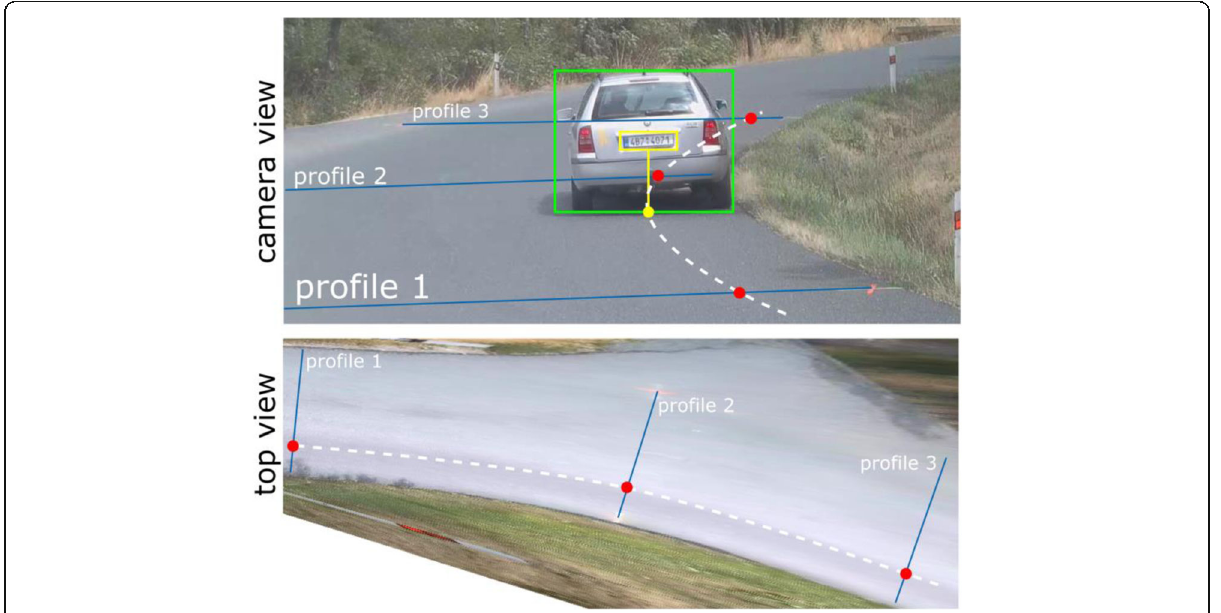
Fig. 5 Illustration of principle of video detection and tracking: in camera view, the position of vehicle on a road plane was calculated as a projection of a centre of vehicle license plate to the lowest detected edge; the transformed positions were approximated by a cubic polynomial into trajectories; and intersections with three profiles were